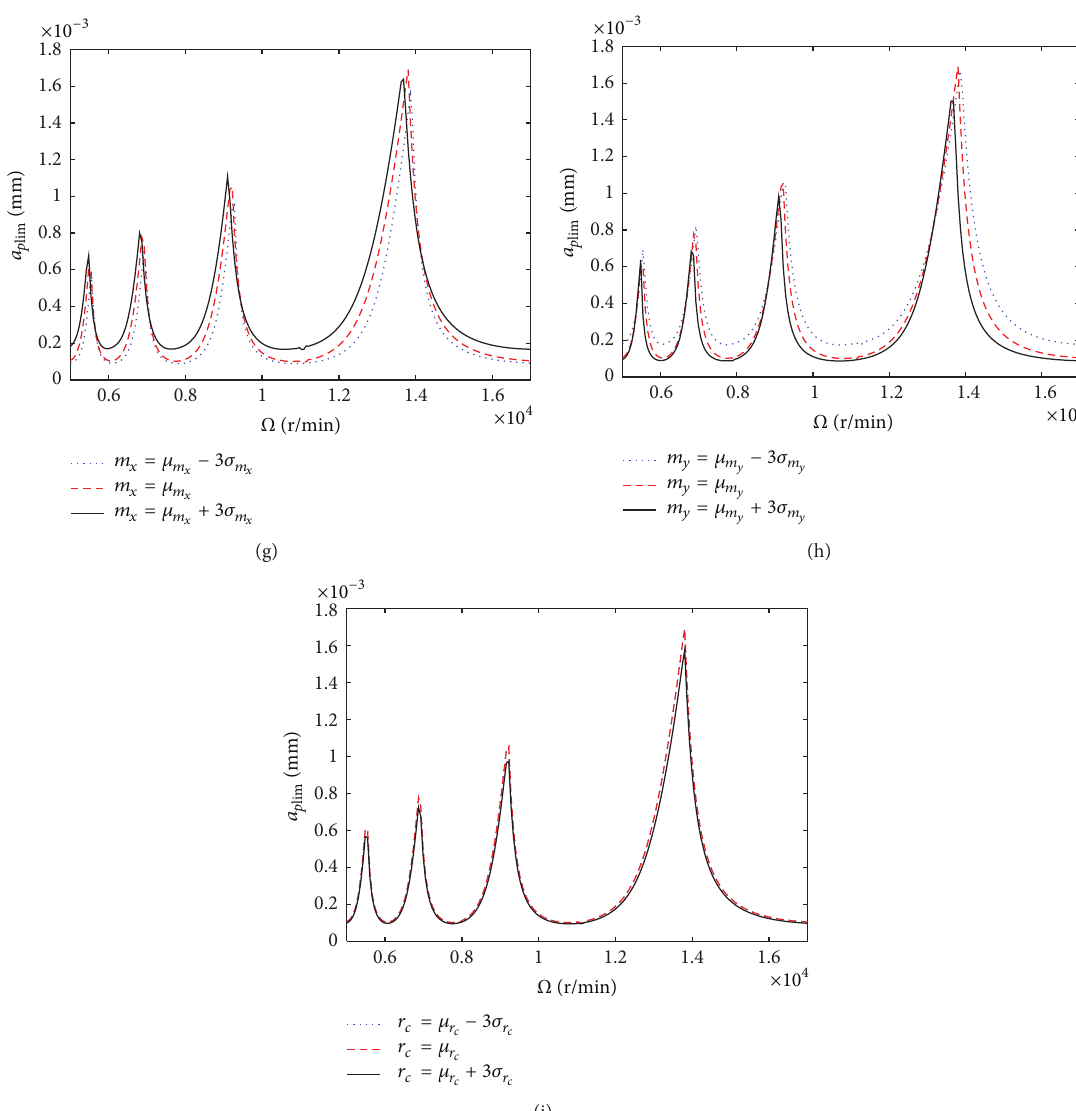
Figure 4: The effects of different variables on the stability boundaries.